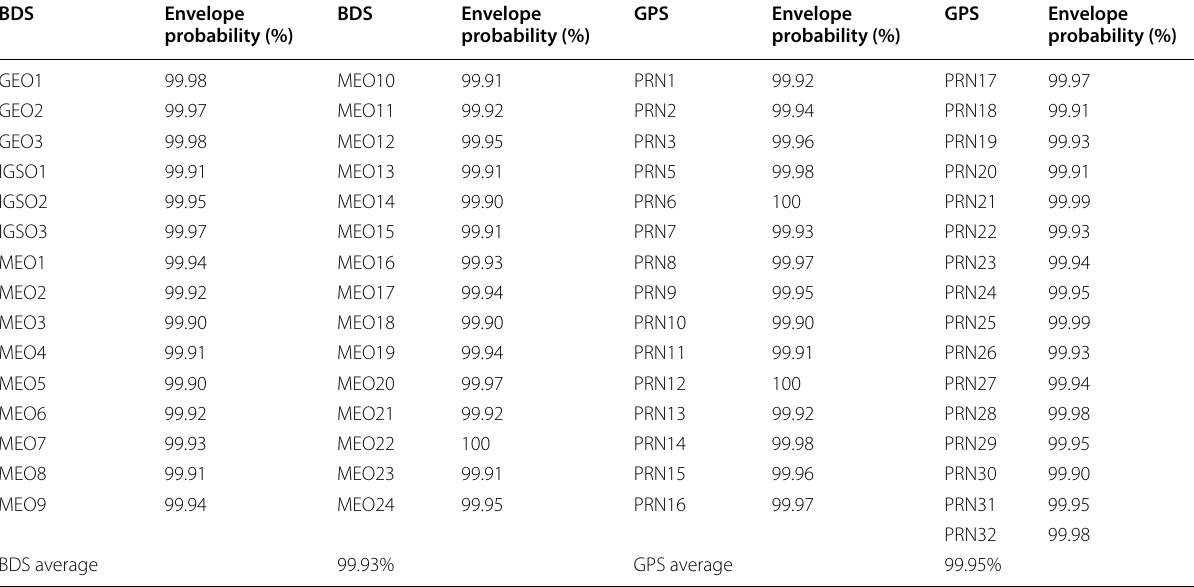
Table 2 DFRE envelope probability of BDS